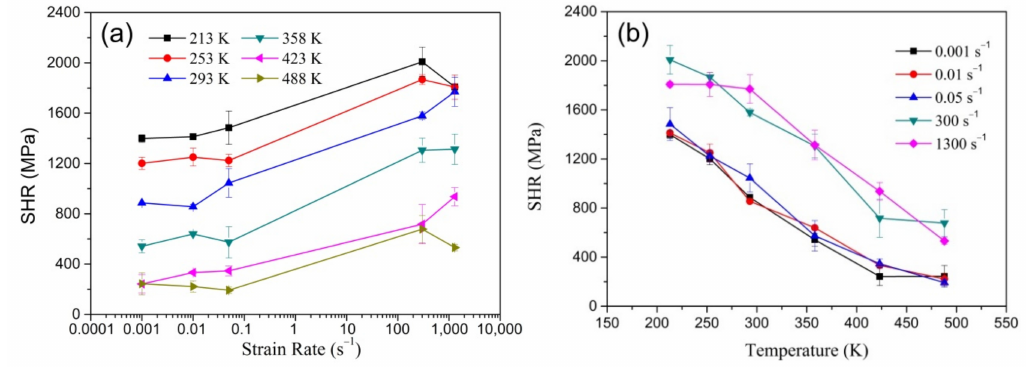
Figure 6. E ff ects of ( a ) strain rate and ( b ) temperature on the average values of strain-hardening